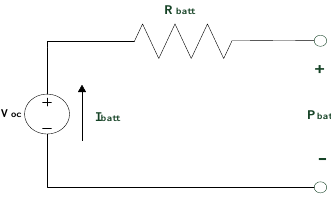
Figure 7. Diagram of battery equivalent circuit.